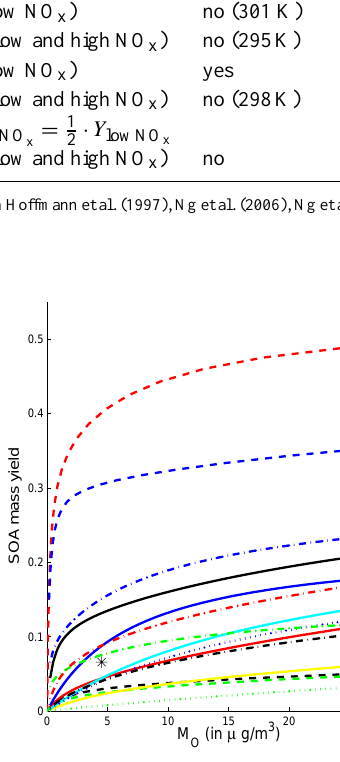
Table 5. Parameterisations for α -pinene SOA based on smog chamber experiments. VBS = Volatility Basis Set. Study Type Oxidant NO x depend. T depend. Radiation